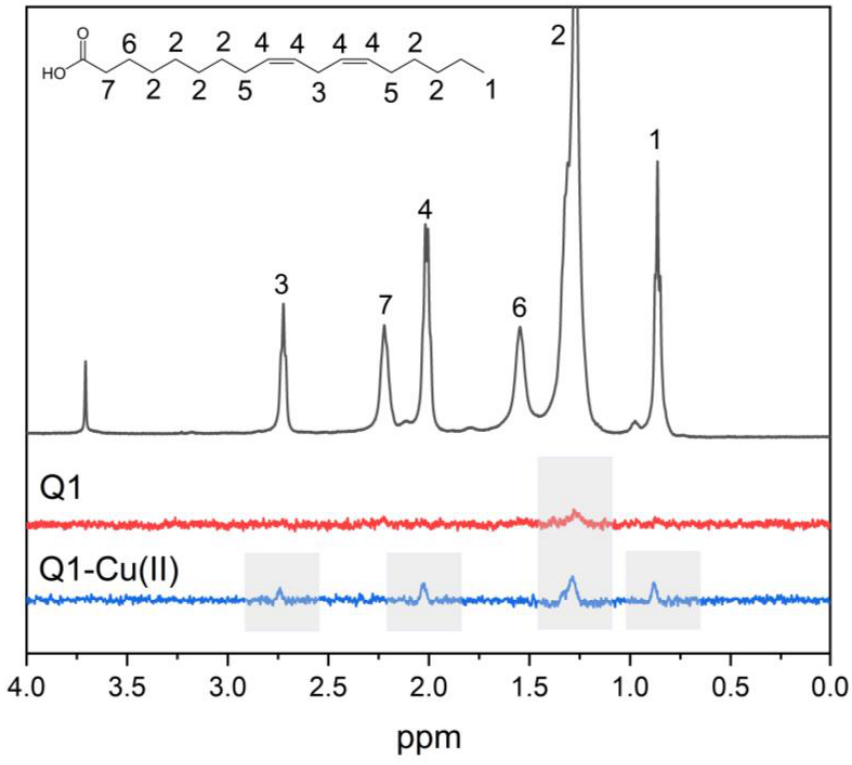
Figure 3. 1D NOESY spectra of Q1 (red line) and the Q1 − Cu(II) complex (blue line) and 1 H NMR spectra (gray line) of Q1 in LA micelles. pH = 7.4. Q1 concentration was 1mM.